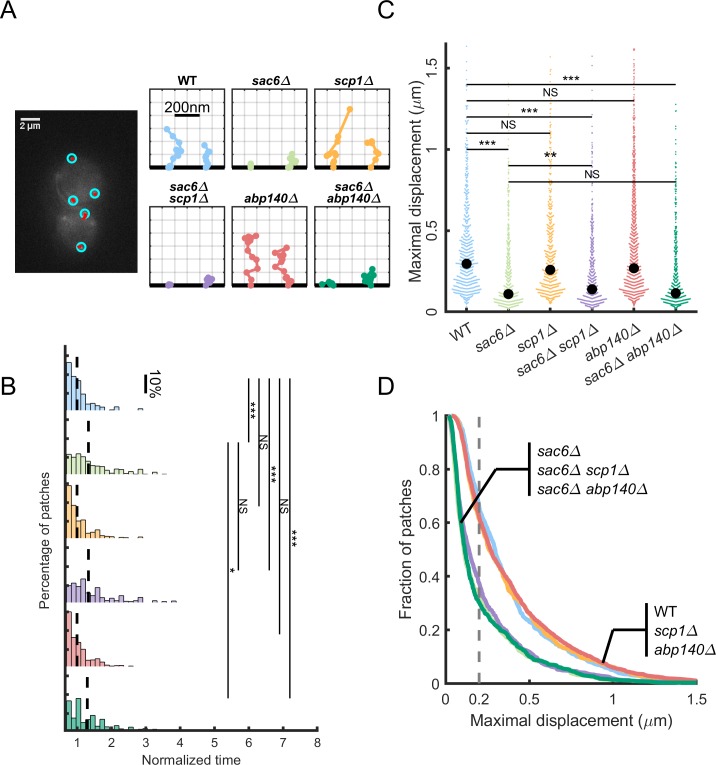
Endocytic phenotypes in S. cerevisiae cells lacking putative crosslinkers.The underlying data can be found within S1 Data. (A) Observation and tracking of endocytic patches in the different strains used in this study. Left: Epifluorescence image of a representative yeast cell expressing Abp1 fused to GFP (Abp1–GFP) and analyzed to obtain the trajectories of its endocytic actin patches. Actin patches are detected (blue circles) and are progressively tracked (red line) using the plugin TrackMate. Right: Plots showing, for the six different strains analyzed in this study, two typical examples of patch trajectories towards the interior of the cell. The plasma membrane is represented by the horizontal bold line tangent to the x axis, while the y axis represents the normal to the membrane and is oriented towards the interior of the cell. Identical scales have been used for the two axes. (B) Histogram of actin patch normalized lifetimes extracted from the analysis for the different strains. Lifetimes are normalized by the median of the WT strain for each replicate. Dashed line is the median. (C) Maximal displacement of the actin patches. The maximal displacement represents the distance between the first point of the trajectory and the furthest point inside the cell. Each colored dot represents a patch. Black dots indicate the median. (D) Endocytosis efficiency. Proportion of patches that have a maximal displacement larger than a given value (x axis) for each strain (same color code as in B). The dashed line at 0.2 μm indicates the typical displacement above which endocytic events have successfully occurred. Abp1, actin-binding protein 1; Abp140, actin-binding protein 140; GFP, green fluorescent protein; NS, not significant; Sac6, yeast homolog of fimbrin; Scp1, yeast homolog of calponin; WT, wild type.